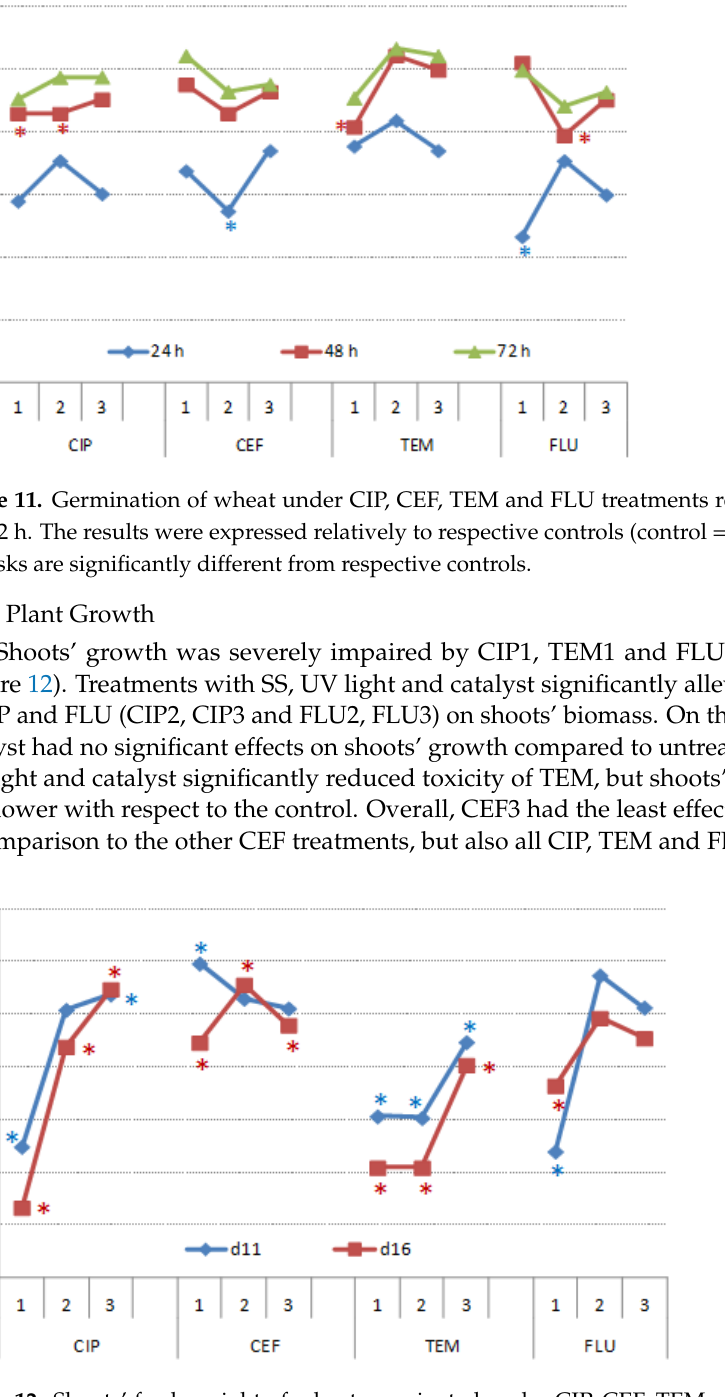
Figure 12. Shoots’ fresh weight of wheat germinated under CIP, CEF, TEM, and FLU treatments and subsequently grown on complete nutrient solution, recorded in 11- and 16-day-old plants. The results are expressed as relative percentages to respective controls (control = 100%). Asterisks indicate significant difference from respective controls.